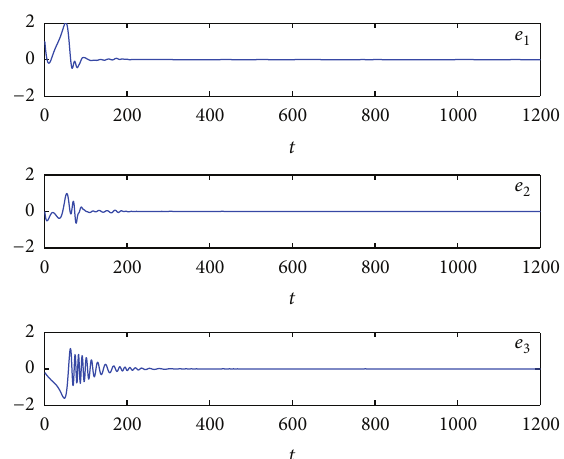
Figure 1: The time evolutions of MFPS errors between system (23) and system (24).